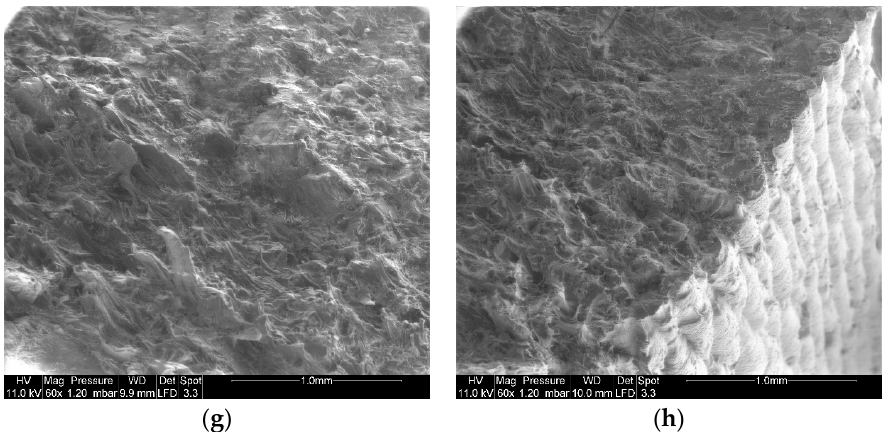
Figure 10. SEM micrographs showing the differences in microstructural arrangement between PLA and PF printed samples. ( a ) PLA printed at 200 °C layup view, ( b ) PLA printed at 200 °C edge view, ( c ) PLA printed at 210 °C layup view, ( d ) PLA printed at 210 °C edge view, ( e ) PF printed at 200 °C layup view, ( f ) PF printed at 200 °C edge view, ( g ) PF printed at 210 °C layup view, and ( h ) PF printed at 210 °C edge view.